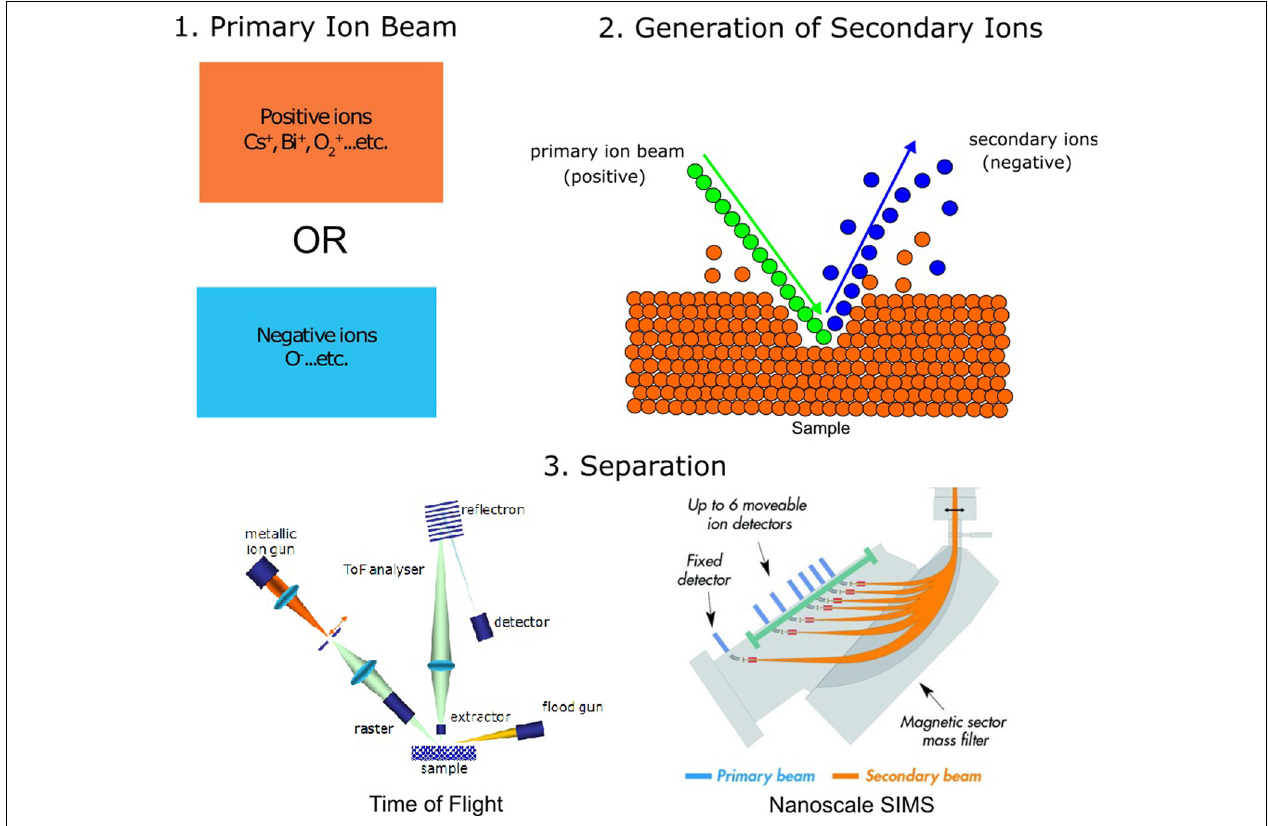
FIGURE 1 | General principles of secondary ion mass spectrometry (SIMS) analysis. (1) SIMS analysis begins by making use of a primary ion beam, which can either be made of positive ions or negative ions. (2) The primary ion beam strikes the analysis surface during sputtering, producing secondary ions. (3) Secondary ions are accelerated towards the detector, either through a flight tube [time-of-flight SIMS, ToF-SIMS; image adapted with permission from Mazel and Richardin (2009) or through magnetic separation using a quadrupole (nanoscale SIMS, NanoSIMS), image adapted with permission from Nuñez et al. (2018)].